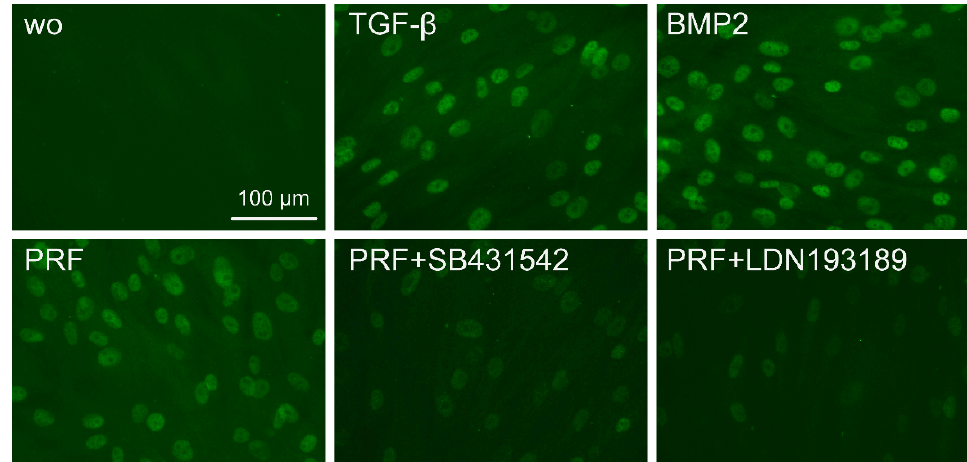
Figure 6. The PRF lysate attenuated the translocation of Smad1/5 from the cytoplasm into the nucleus. Gingival fibroblasts were exposed to TGF-β and BMP2 as positive controls and PRF in the presence or absence of SB431542 and LDN193189. Immunofluorescence analysis of the intracellular translocation of Smad1/5 into the nucleus is presented. ”wo” indicates without and represents unstimulated cells.